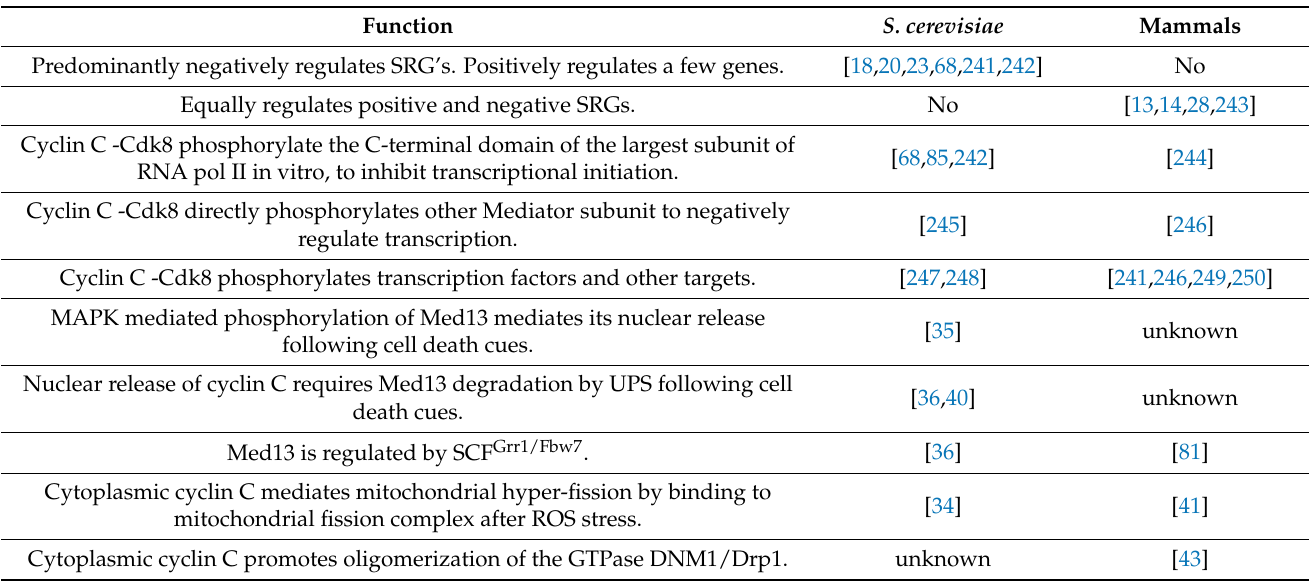
Table 1. Summary of the known roles of CKM following ROS stress and TORC1 inhibition in yeast and mammals. Function Predominantly negatively regulates SRG’s. Positively regulates a few genes. Equally regulates positive and negative SRGs. Cyclin C -Cdk8 phosphorylate the C-terminal domain of the largest subunit of RNA pol II in vitro , to inhibit transcriptional initiation. Cyclin C -Cdk8 directly phosphorylates other Mediator subunit to negatively regulate transcription. Cyclin C -Cdk8 phosphorylates transcription factors and other targets. MAPK mediated phosphorylation of Med13 mediates its nuclear release following cell death cues. Nuclear release of cyclin C requires Med13 degradation by UPS following cell death cues. Med13 is regulated by SCF Grr1/Fbw7 . Cytoplasmic cyclin C mediates mitochondrial hyper-fission by binding to mitochondrial fission complex after ROS stress. Cytoplasmic cyclin C promotes oligomerization of the GTPase DNM1/Drp1. Cyclin C nuclear release is required for RCD (intrinsic pathway). Cyclin C binds to BAX at mitochondria to induce MOMP following ROS stress.